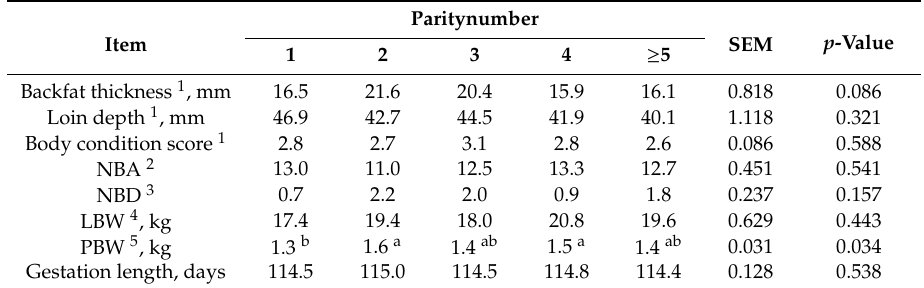
Table 1. Influence of parity number on body condition and gestation length of sows and litter parameters at birth.